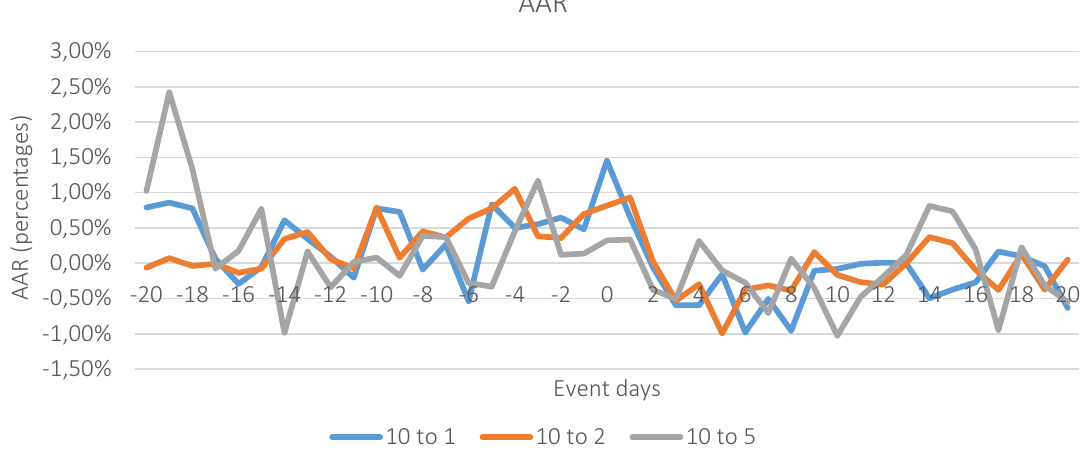
Figure 3. AARs – Announcement Day (different stock split